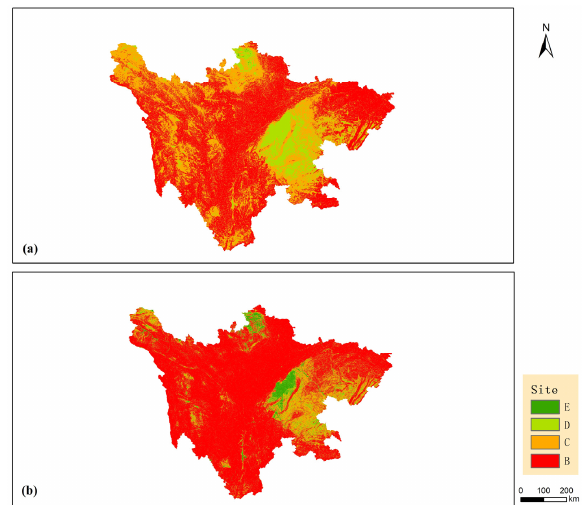
Figure 8. (a) The result of site classification in Sichuan Province obtained from 30 arcsec DEM data. (b) The result of site classification in Sichuan Province obtained from 3 arcsec DEM